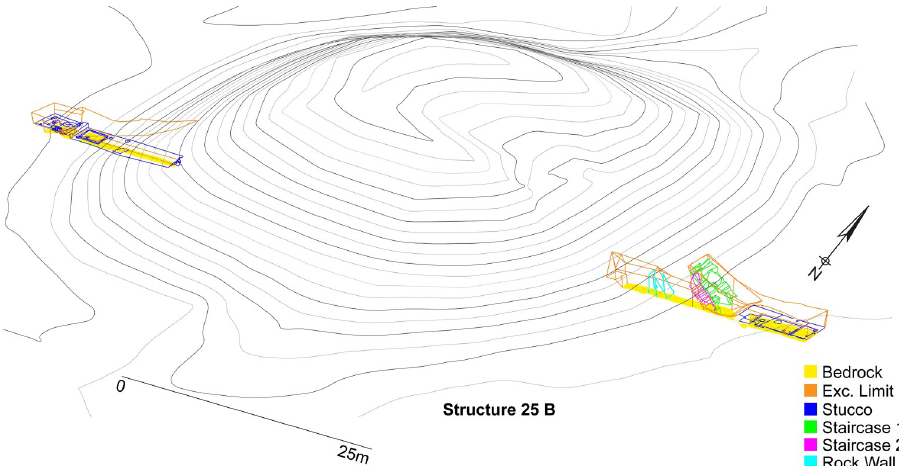
Fig 7. 3D AutoCAD drawing of trench and tunnel excavations of structure 25B indicating height of bedrock (yellow). Published under a CC BY license, with permission from S. Sugiyama, original copyright Moon Pyramid Project 2021.